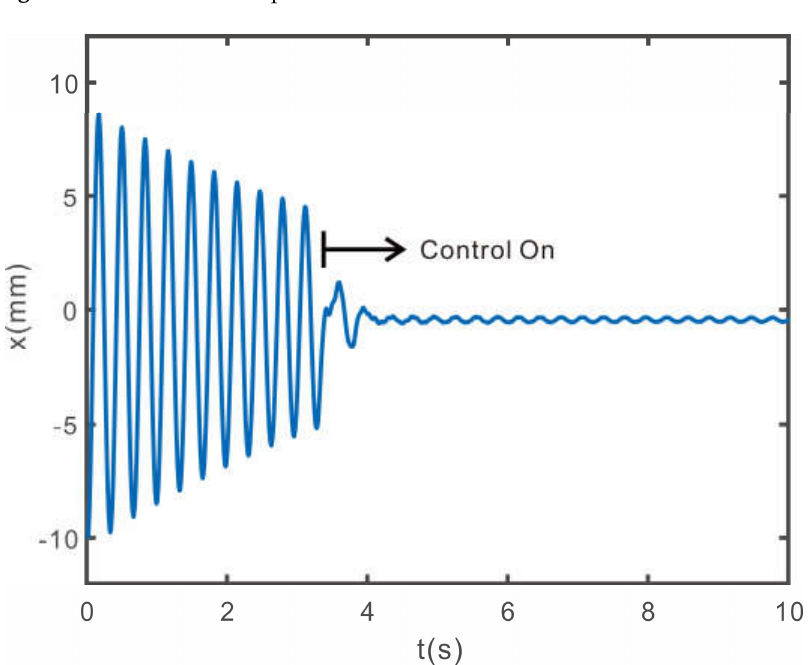
Figure 10. Free vibration experiment.